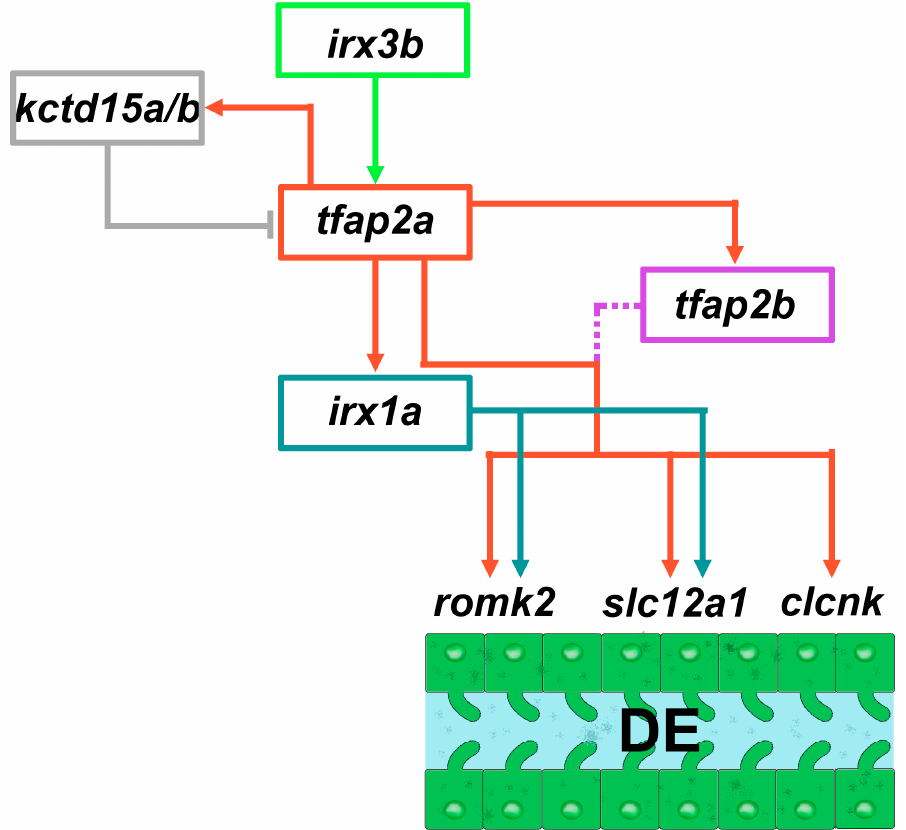
Figure 5. Working model of components in the Tfap2 gene regulatory network that controls distal segment differentiation during zebrafish pronephros development. tfap2a is positioned as an intermediary factor within a cascade of the irx3-irx1a transcription factors that promote DE formation. Furthermore, tfap2a positively regulates the expression of tfap2b , and auto-regulates itself by modulating the expression of the kctd15a/b repressors. Adapted from Ref. [148,149].